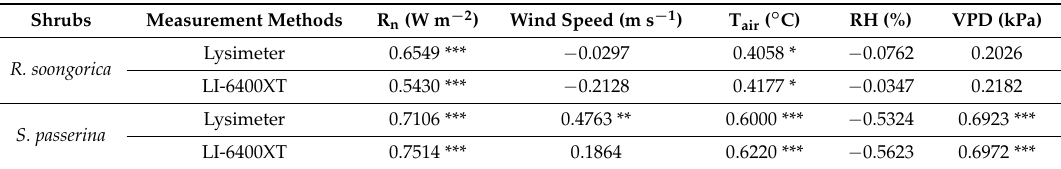
Table 4. Summary of correlations (Pearson) between the transpiration rates ( T r , mm h − 1 ) and meteorological factors at the canopy